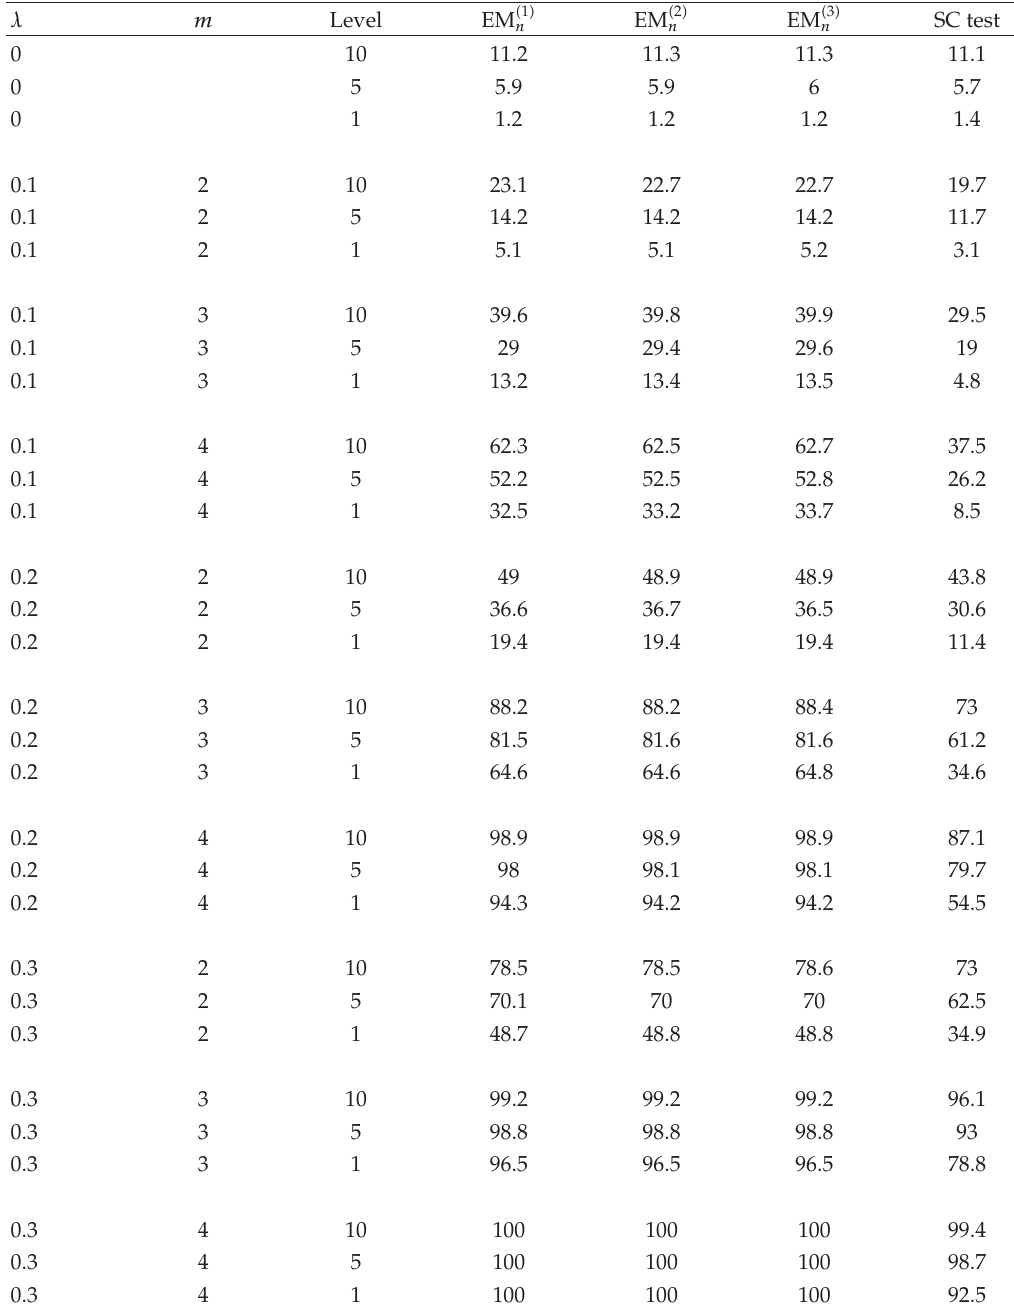
Table 4: Type I error and power comparisons (cid:2) % (cid:3) of the EM test and the score test (cid:2) SC test (cid:3) for gamma model: n 0 (cid:5) n 1 (cid:5)